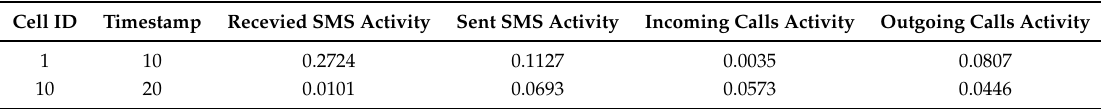
Table 1. Telecom Italia dataset